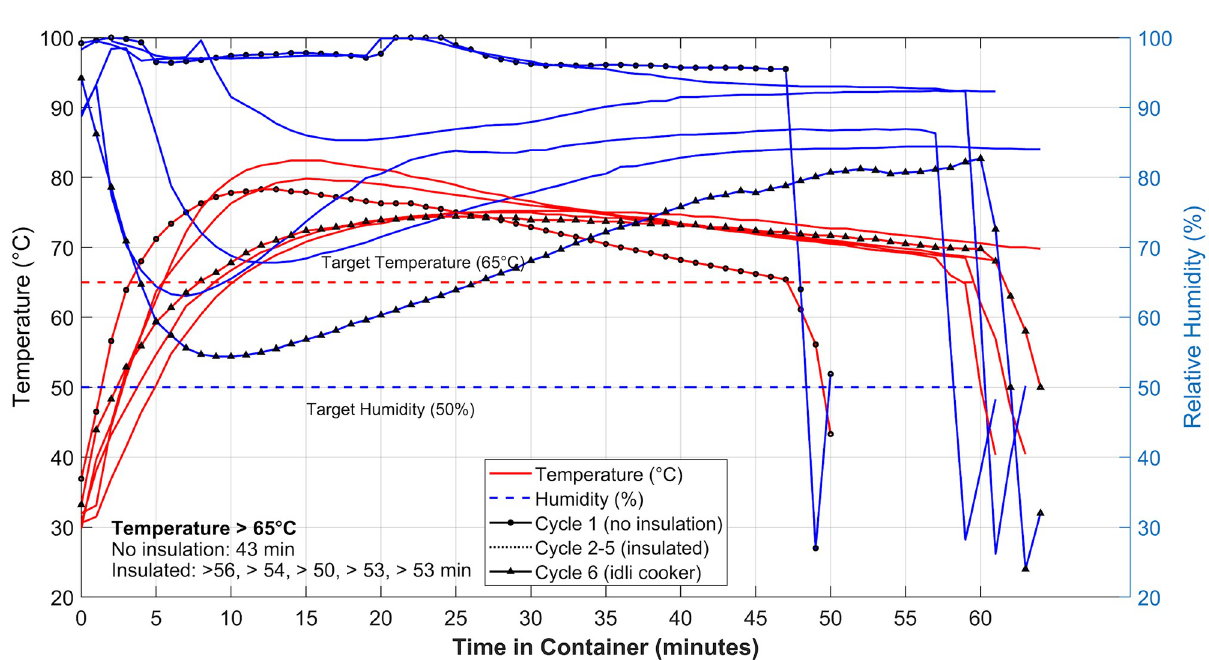
Fig 10. Temperature and relative humidity inside the container holding the single N95 FFR during the 5 treatment cycles and the 6 th cycle in an “idli-cooker” (container with 4 FFR capacity). A sudden decrease in humidity followed by a recovery is noticed on opening the container at the end of the run. (For two cycles in which there was either no sealing or a leak in the seal of the inner vessel the RH values are close to